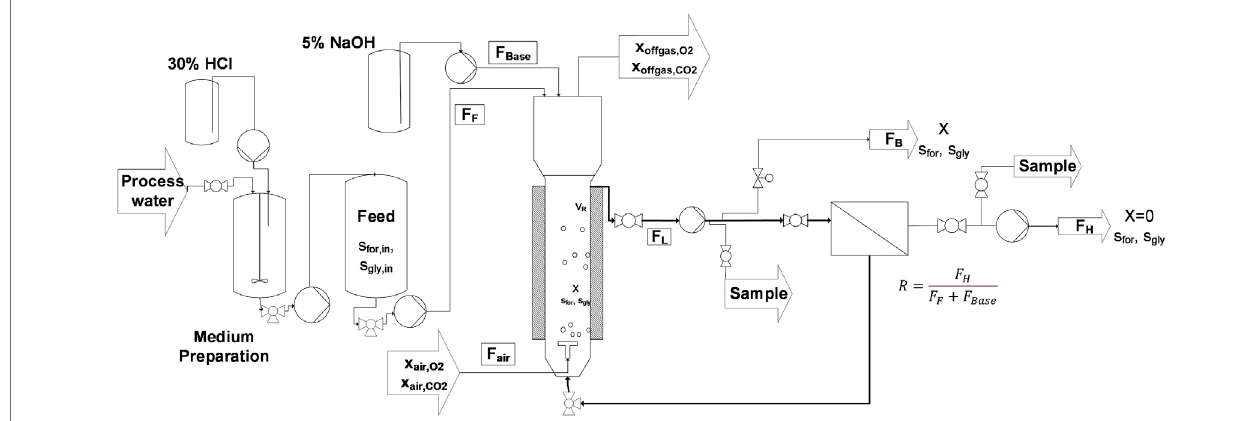
FIGURE1| Schemeofthefermentationsetup.ResidualprocessbrinefromtheMDAproductionispreparedandsupplementedwiththerequiredcomponentsina fi rst200 Lvessel.Fromtherethemediumispumpedintothefeedvessel,fromwhereaconstantfeed(FF)suppliesthecellswithfreshsubstrateandmediacomponents. 5%NaOH(FBase)isaddedtoholdthepHonaconstantlevelof7.0.Apumpcontinuouslycirculatesthecellsuspensionasloop fl ow(FL)throughthemembranemodule to separate cell-free harvest (FH). The ratio of outgoing harvest fl ow to the total iput fl ow is called the retention rate R and is calculated according to the following equation: R